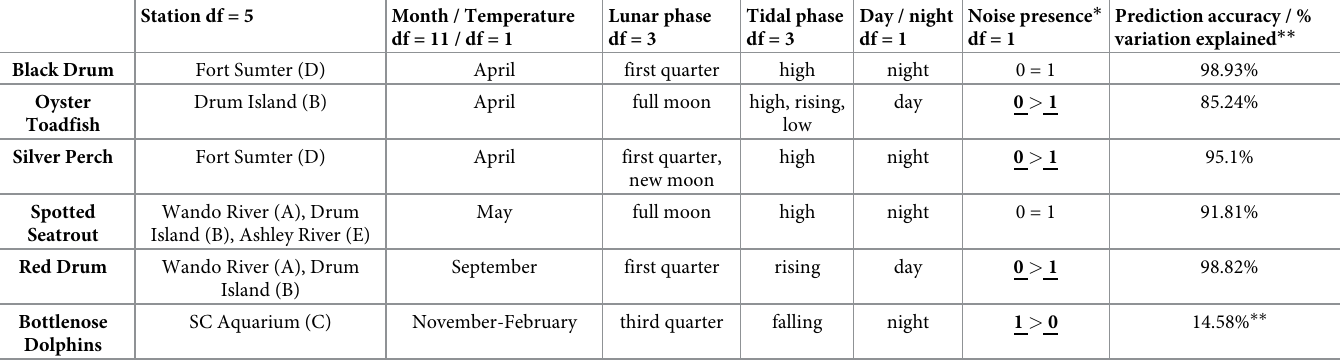
Table 3. Top ranked variable for each random forest model for black drum, oyster toadfish, silver perch, spotted seatrout, red drum, and bottlenose dolphin vocali- zations. Blank cells indicate that variable was not included in the associated model. Fig 6 shows the relative rank of each factor. Station df = 5